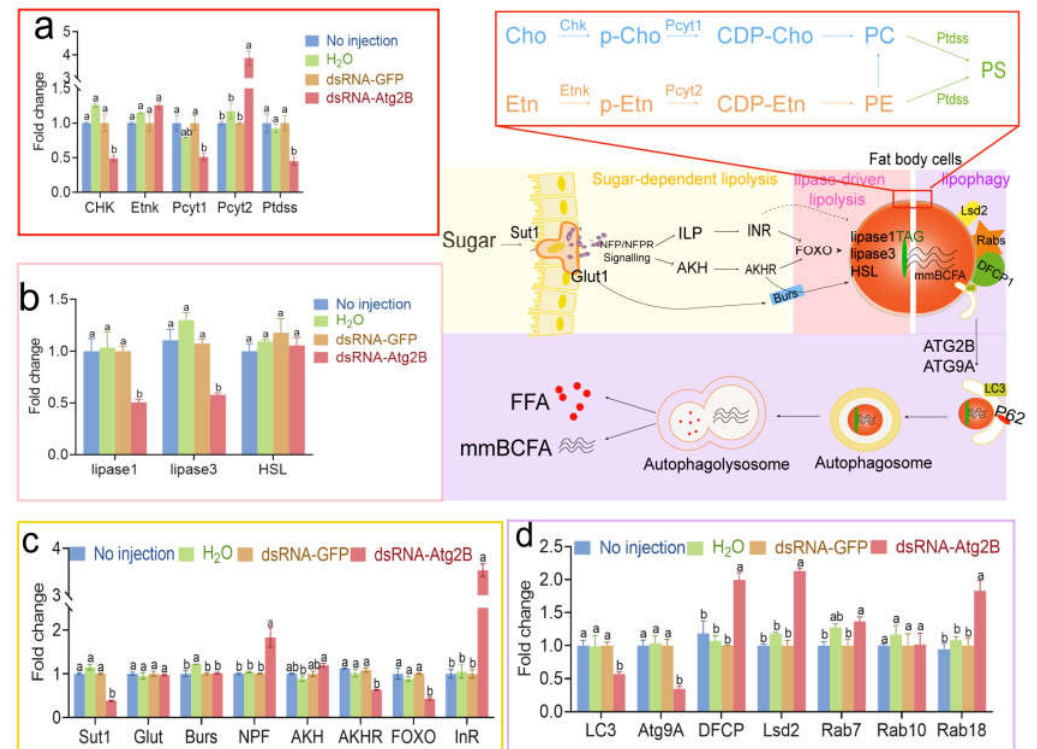
Figure 6. Fold changes of genes related to lipid lipolysis after knockdown the AmAtg2B of pupae in Apis mellifera . ( a ) Fold changes of LC3 and genes for lipid droplet ( ATG9A , DFCP1 , Lsd2 , Rab7 , Rab10 and Rab18 ); ( b ) fold changes of genes for traditional lipase-driven lipolysis ( lipase1 , lipase3 and HSL); ( c ) fold changes of genes for the regulation of sugar-dependent lipolysis ( Sut1 , Glut , Burs , NPF , AKH , AKHR , HSL , FOXO and InR ); ( d ) qRT-PCR analysis of expression of genes encoding rate-limiting enzymes in phospholipid synthesis pathways after knockdown the AmAtg2B of pupae. Note: Data are shown as mean ± SEM and the different letters marked on the bar chart represent significant differences ( p < 0.05).